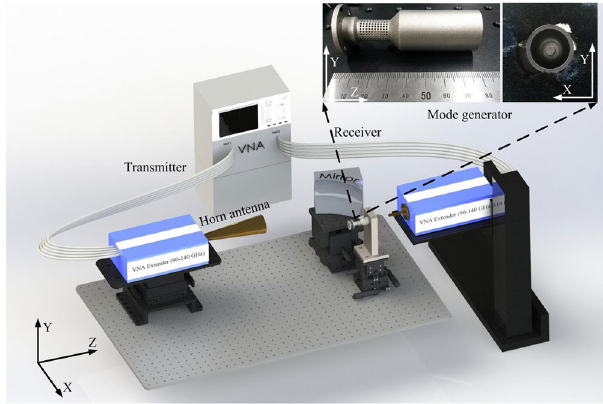
Figure 8. Experimental setup for the generation of rotating higher–order TE modes. Inset: QO-mode generator and inner rod.